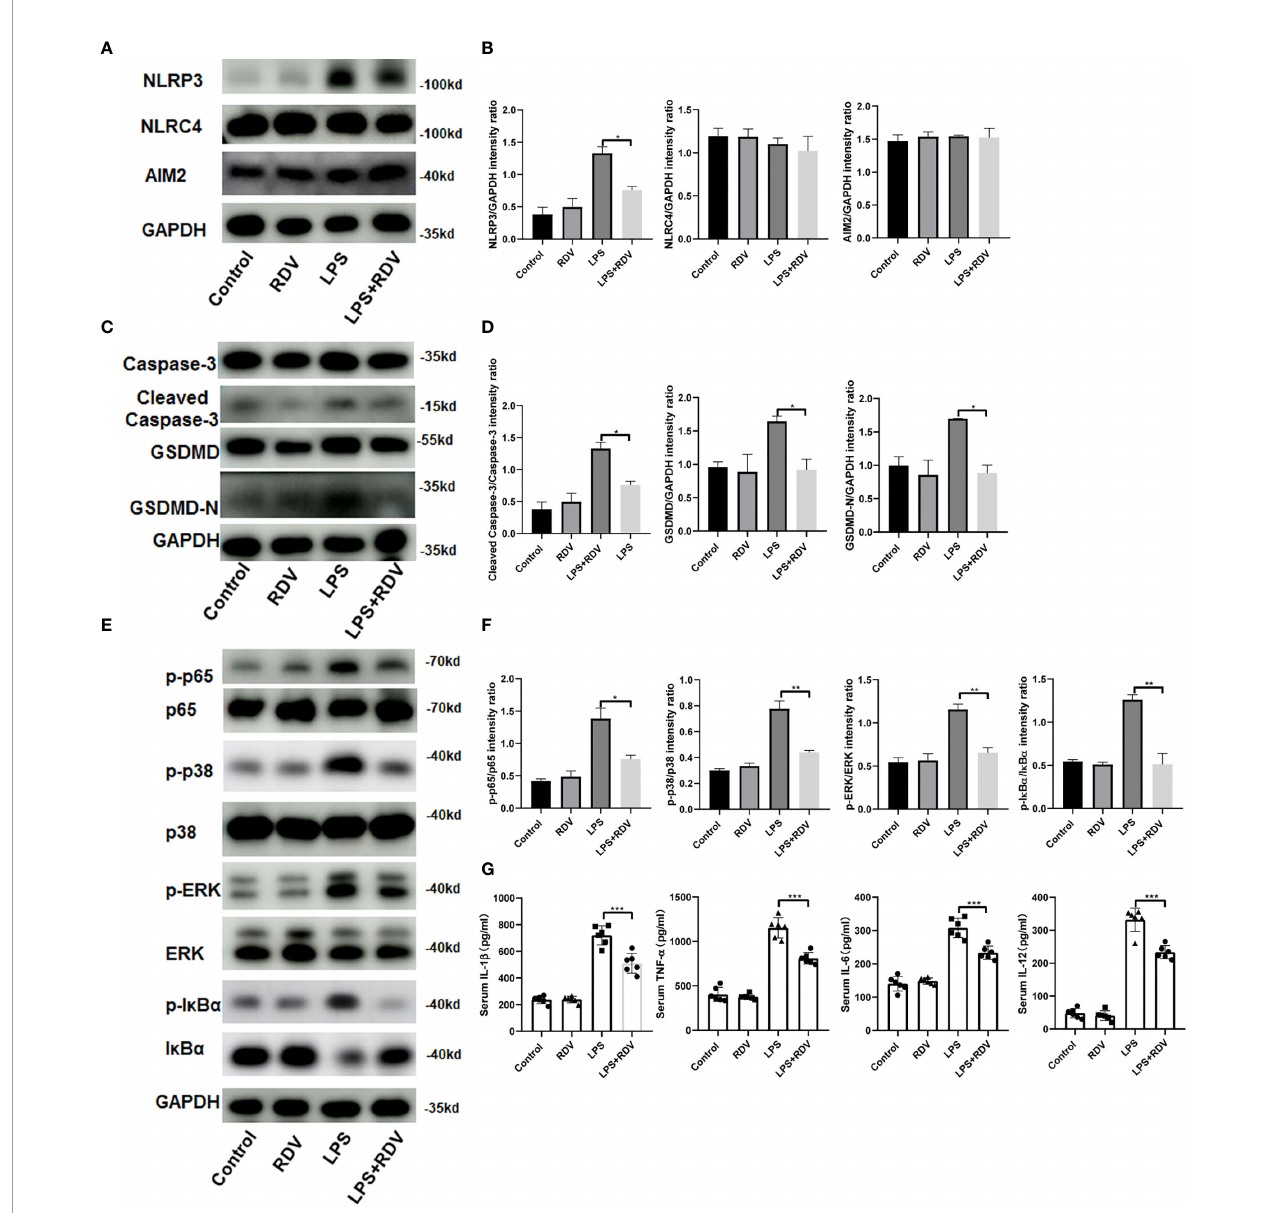
FIGURE 5 | Effects of RDV on in fl ammatory injury in LPS-induced AKI mice. (A) Western blot analysis of NLRP3, NLRC4 and AIM2 in kidneys. (B, D, F) Relative intensity analysis of NLRP3, NLRC4, AIM2, p-ERK/ERK, p-I k B a /I k B a , cleaved-caspse-3/caspase-3, GSDMD/GAPDH, GSDMD-N/GAPDH. (C) Key points of apoptosis and pyroptosis pathways in kidneys were detected by Western blot. (E) Western analysis of p-p65/p65, p-p38/p38, p-I k B a /I k B a . (G) ELISA analysis of serum level of IL-1 b , IL-6, TNF- a , IL-12. Data are representative as mean values ± SD from three independent experiments. *P < 0.05; **P < 0.01; ***P <